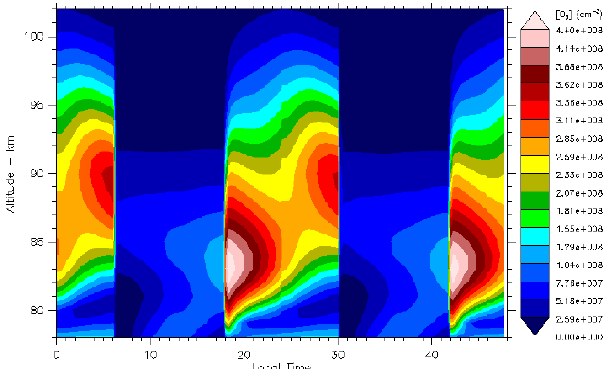
Fig. 5a. ACE-FTS mixing ratio observations for April 2005 sunrise and sunset at the Equator showing the effects of the diurnal tides on CO and H 2 O. The tides are out of phase, as expected, since the changes in mixing ratio profiles with altitude are of opposite sign.